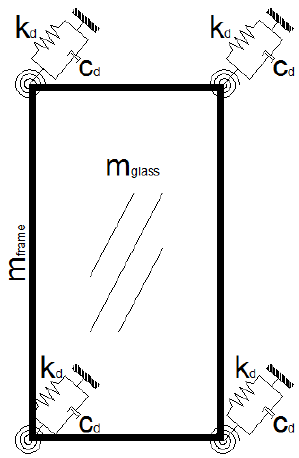
Figure 5. Schematic curtain wall equipped with four viscoelastic